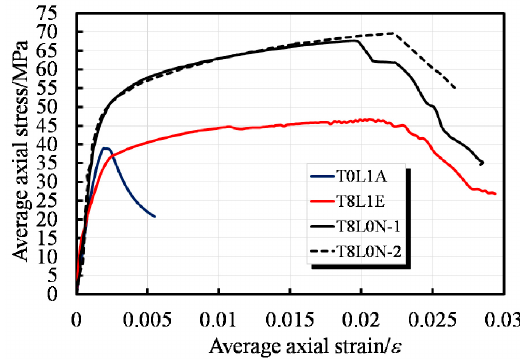
Figure 6. Average stress–strain curves of specimens.